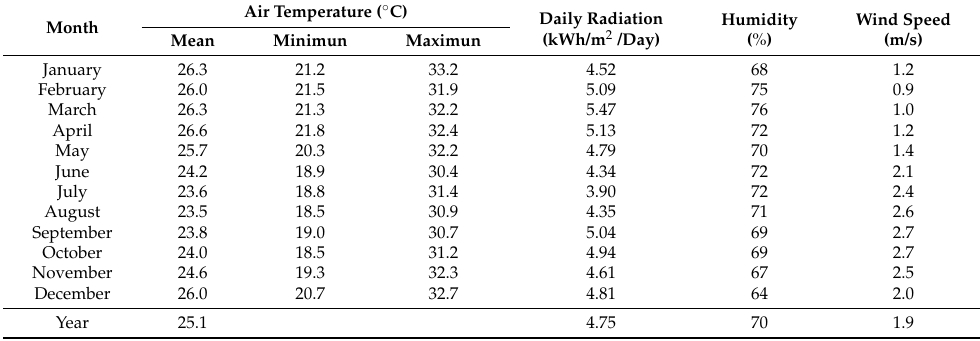
Table 1. Annual summary of meteorological data from the